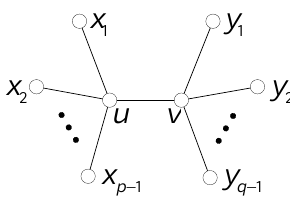
Figure 3. The bi-star S p , q